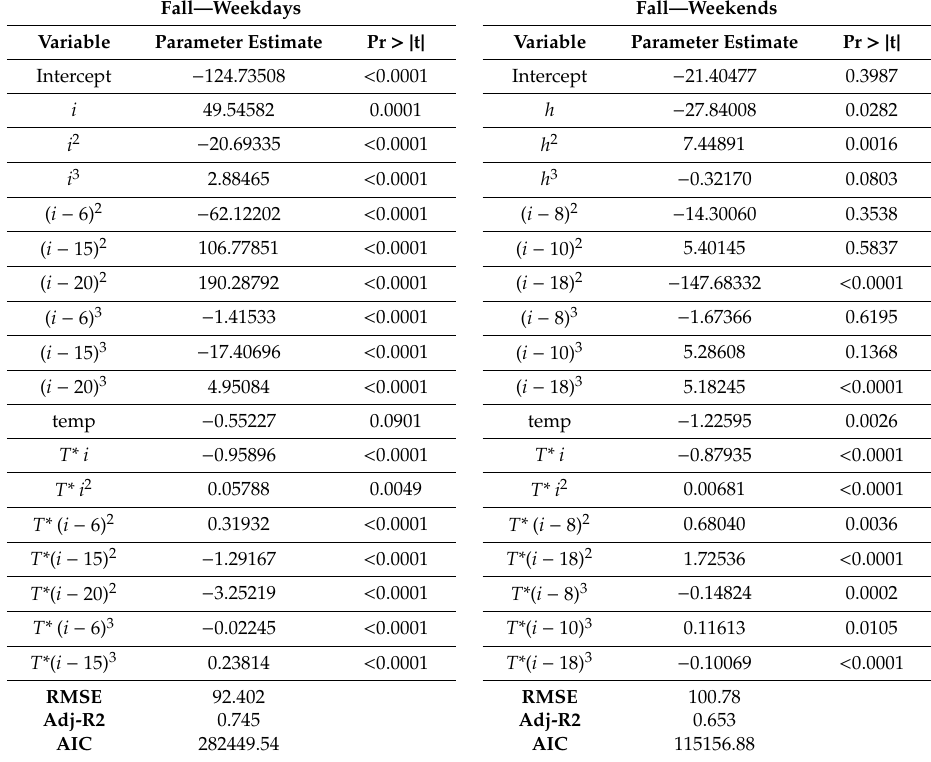
Table A5. The Results for the Regression Model for the Fall Season (Model